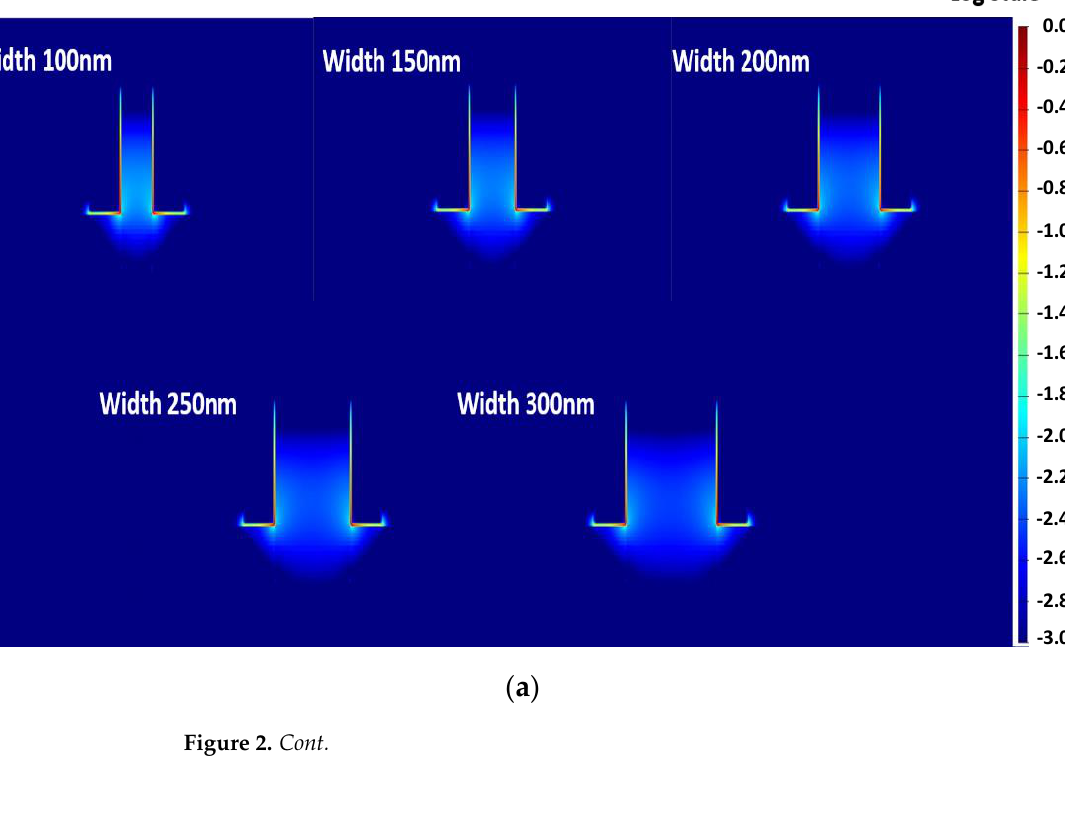
Figure 1. Schematic drawing of the carrier-injection plasmonic micro-ring modulator (CIPMRM). 3. Carrier-Injection Plasmonic Micro-Ring Modulator